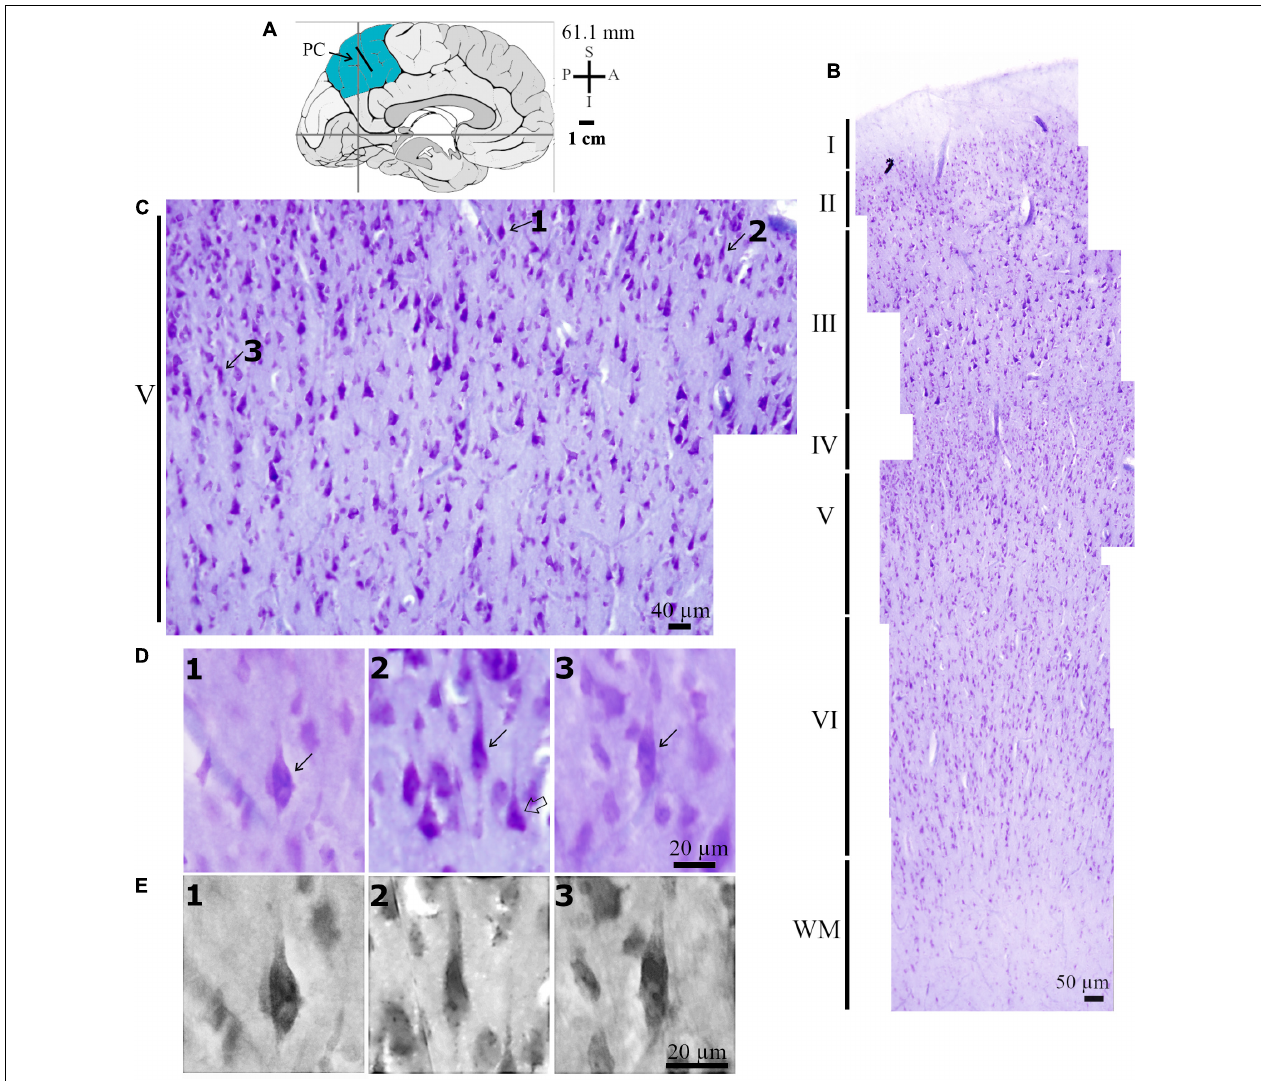
FIGURE 3 | (A) Left: Schematic drawing of the medial view of the human brain and the location of the central region of the precuneus (PC, highlighted in blue), in this case 61.1 mm posterior to the midpoint of the anterior commissure. The dark bar indicates approximately the place where histological data were obtained. Adapted from Mai et al. (2008, 2016). Coordinates: I, inferior; L, lateral; M, medial; S, superior. (B) Photomicrograph of Nissl-stained cells in layers I to VI in the intermediate PC. WM, white matter. (C) Photomicrograph in higher magnification of Nissl-stained cells in the layer V of the human PC as shown in (B) . The spindle-shaped neurons (numbered 1–3 and pointed by solid arrows) are close to pyramidal neurons and other local cells in the cortical layer V and in the transition to layer VI. (D) Further detail for the morphology of these spindle-shaped neurons indicated in (C) . Note their characteristic elongated cell body and two perpendicularly oriented primary dendrites, one with an ascending and another with a descending spatial orientation in the neuropil. Compare these spindle-shaped cells to the neighboring stained pyramidal neurons (example indicated by open arrow). (E) Higher magnification of the same spindle-shaped neurons shown in (D) to evidence the aspect of their chromatin and nucleolus. Scales are shown in each figure. Image adjustment of contrast and brightness made with Photoshop CS3 (Adobe Systems, Inc., United